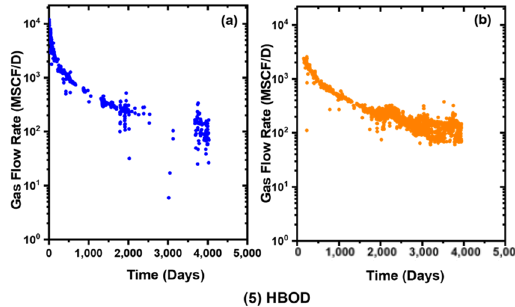
Figure 16. ( a ) Removed outliers and ( b ) production data after removing the outliers of Well_12 using; ( 1 ) MCD, ( 2 ) OCSVM, ( 3 ) PCA, ( 4 ) IF, and ( 5 ) HBOD algorithms.